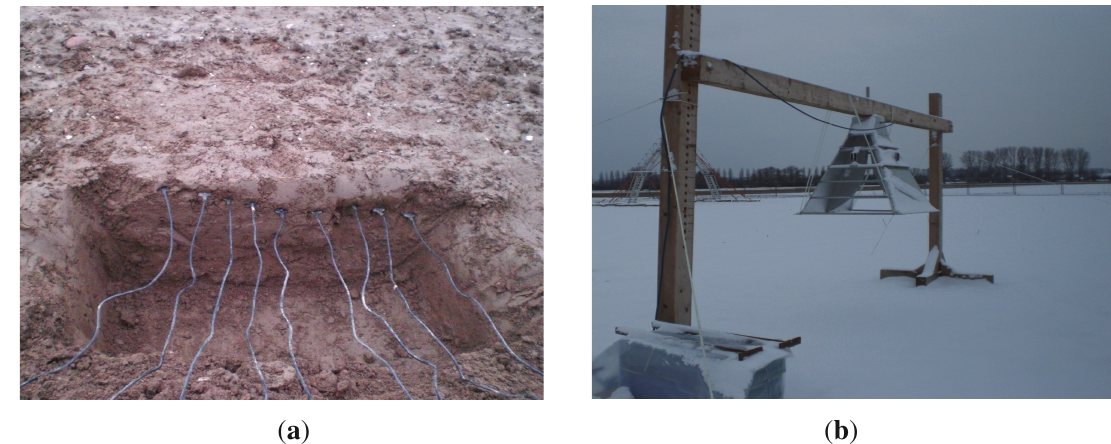
Figure 2. Decagon EC-TM capacitance probes were installed near the footprint of the ground-penetrating radar (GPR) antenna in a trench to monitor the vertical and